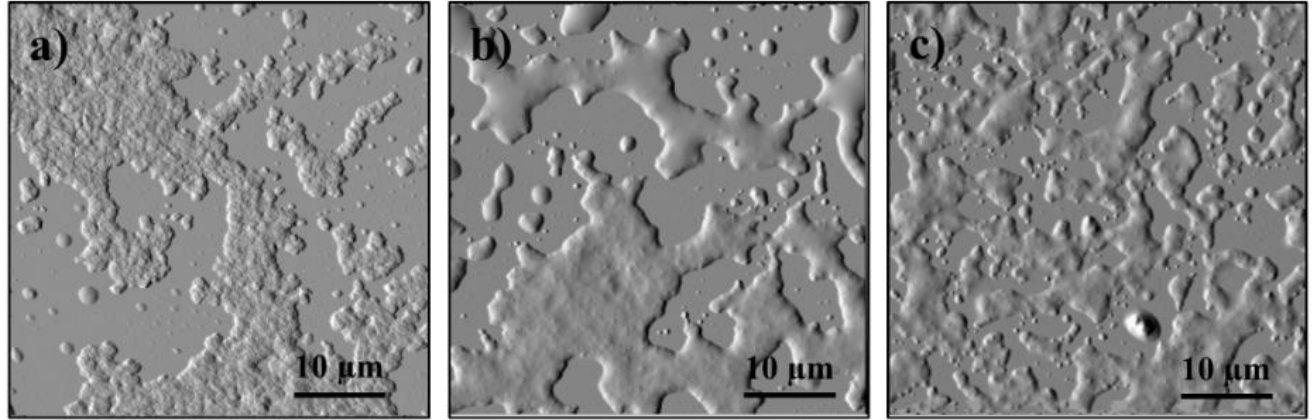
Figure 6. Comparison of the morphology of the resulting (after evaporation) state compared to ( a ) Initial conditions of model 1 after addition of ( b ) APR and ( c ) PIBSA.